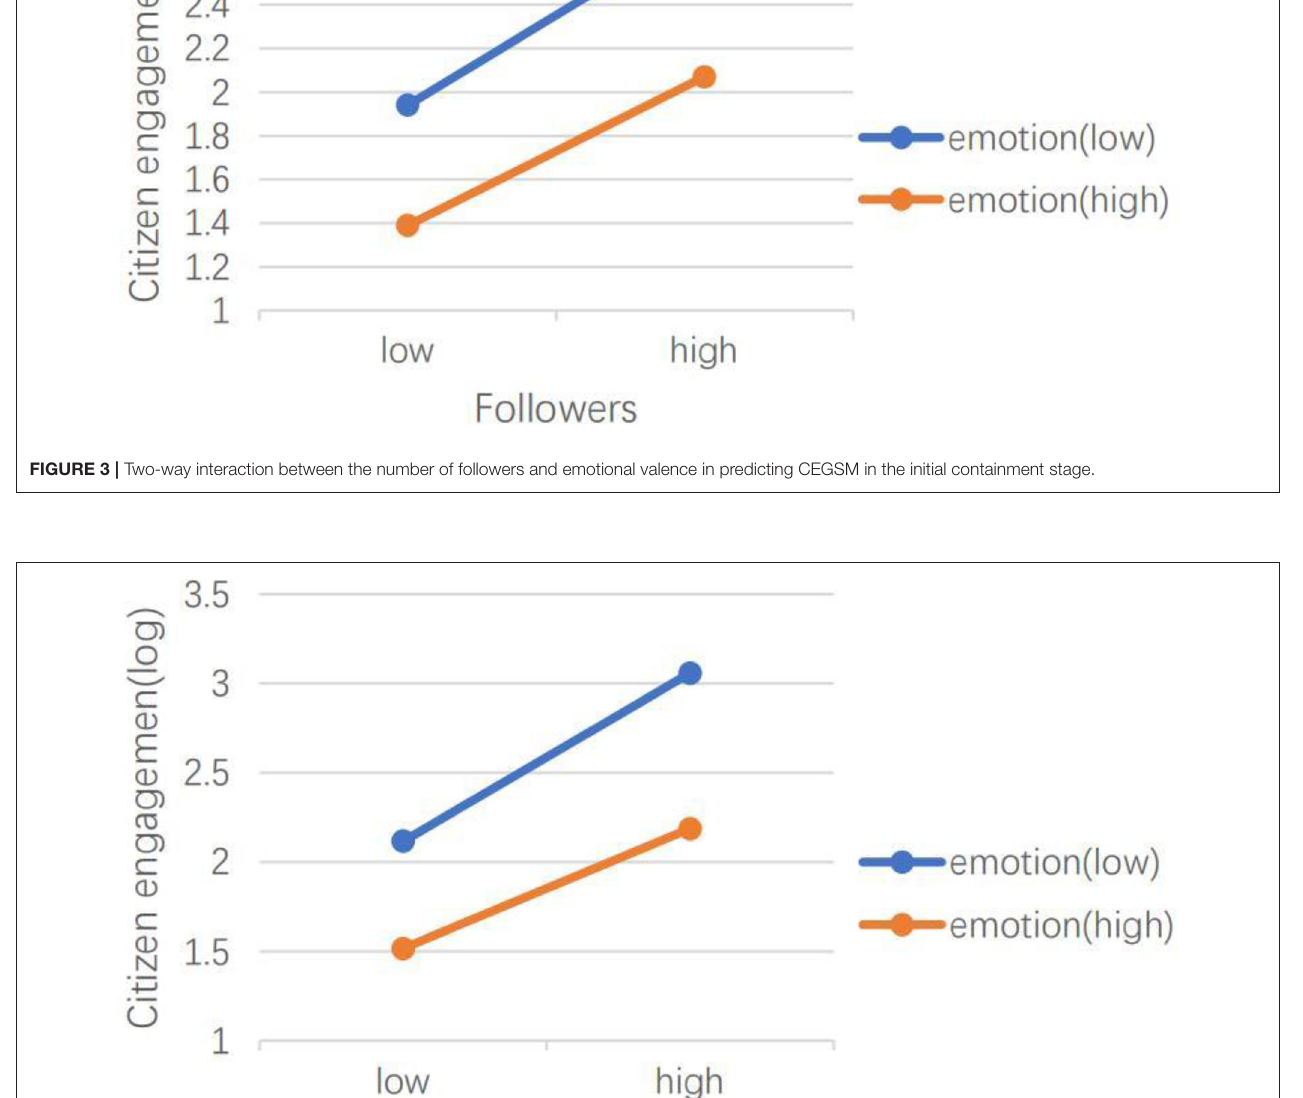
Figures 6 , 7 , the difference between positive emotion posts and negative emotion posts is most significant when there are many followers and followees. As shown in Figure 8 , the difference between posts with positive emotions and negative emotions